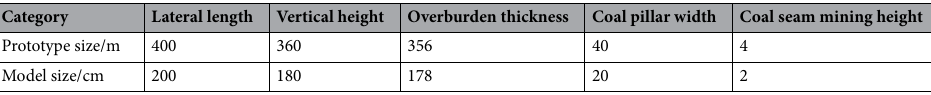
Table 3. Model size and mining